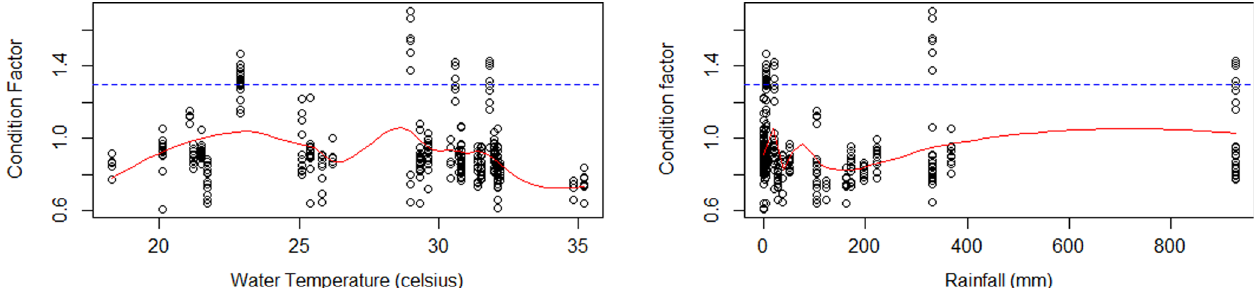
Fig. 7. Climate preferendum for attainment of K spawn 50 in J. coitor in river Ganga. Dotted lines represent estimated K spawn 50 .